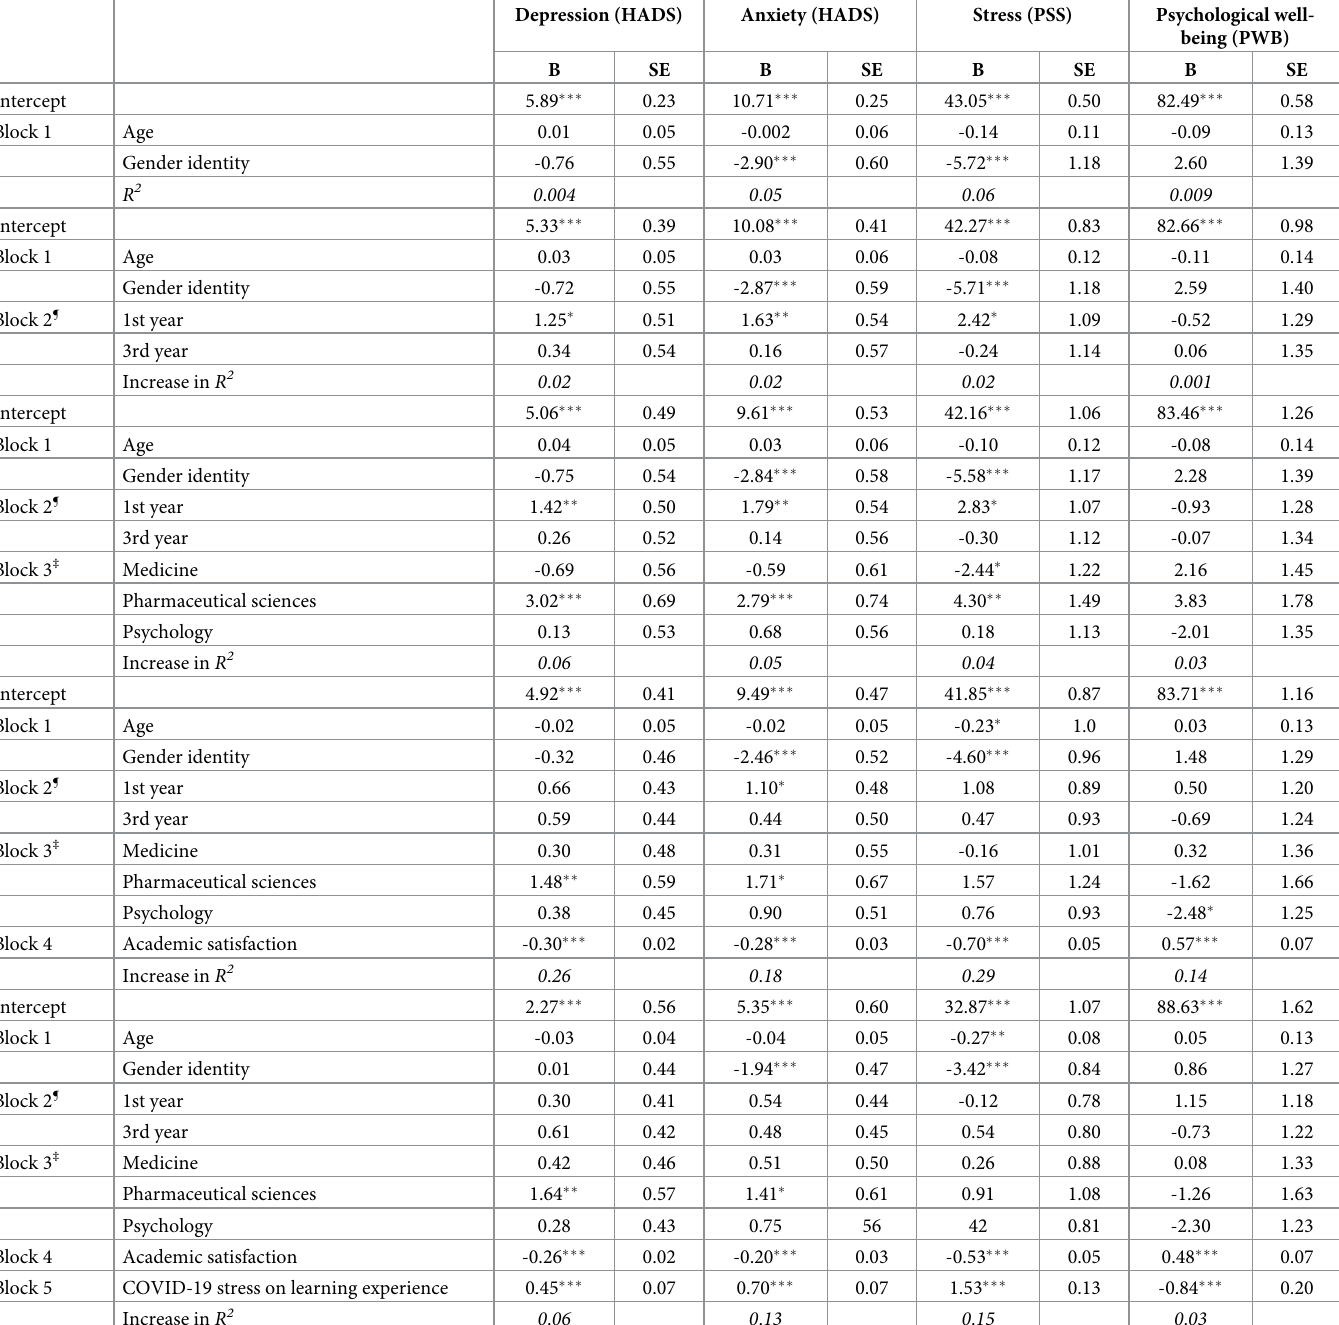
Table 2. Hierarchical